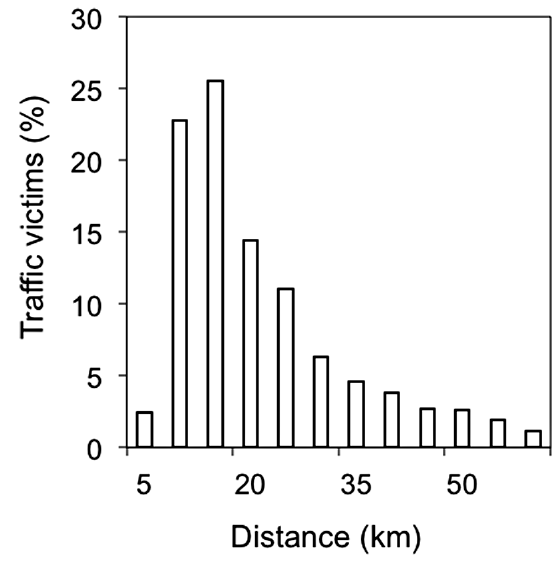
Fig. 6 . The distance between hatching site and location where a bird was found dead (N = 994). Fifty percent of all casualties occurred within 15 km from their natal nest